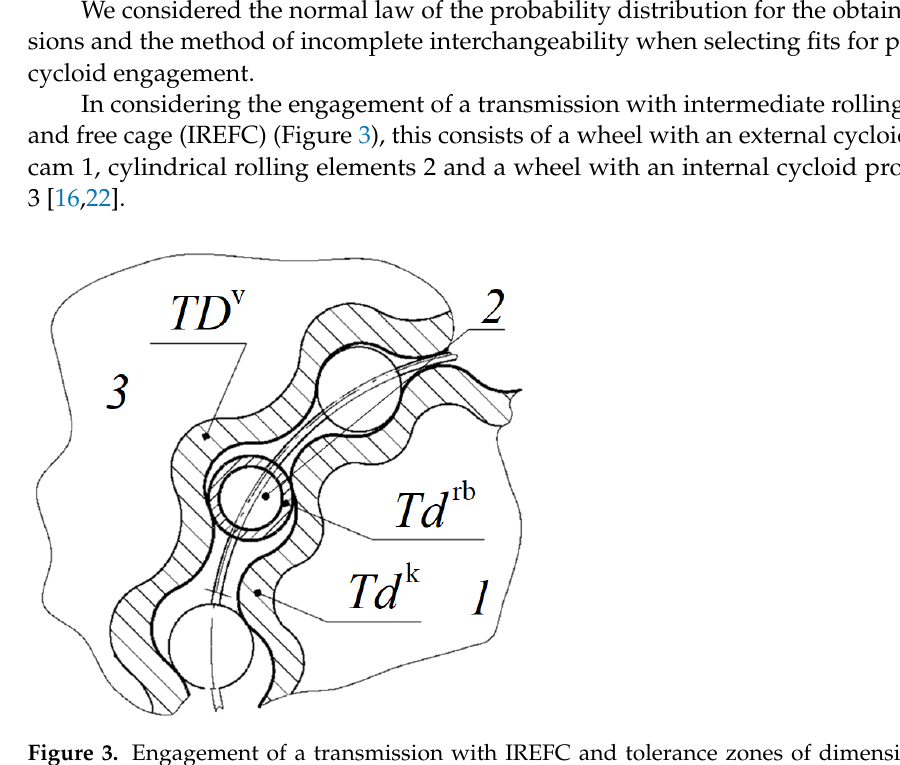
Figure 3. Engagement of a transmission with IREFC and tolerance zones of dimensions of link contacting surfaces: 1—cam; 2—intermediate rolling elements; 3—ring.